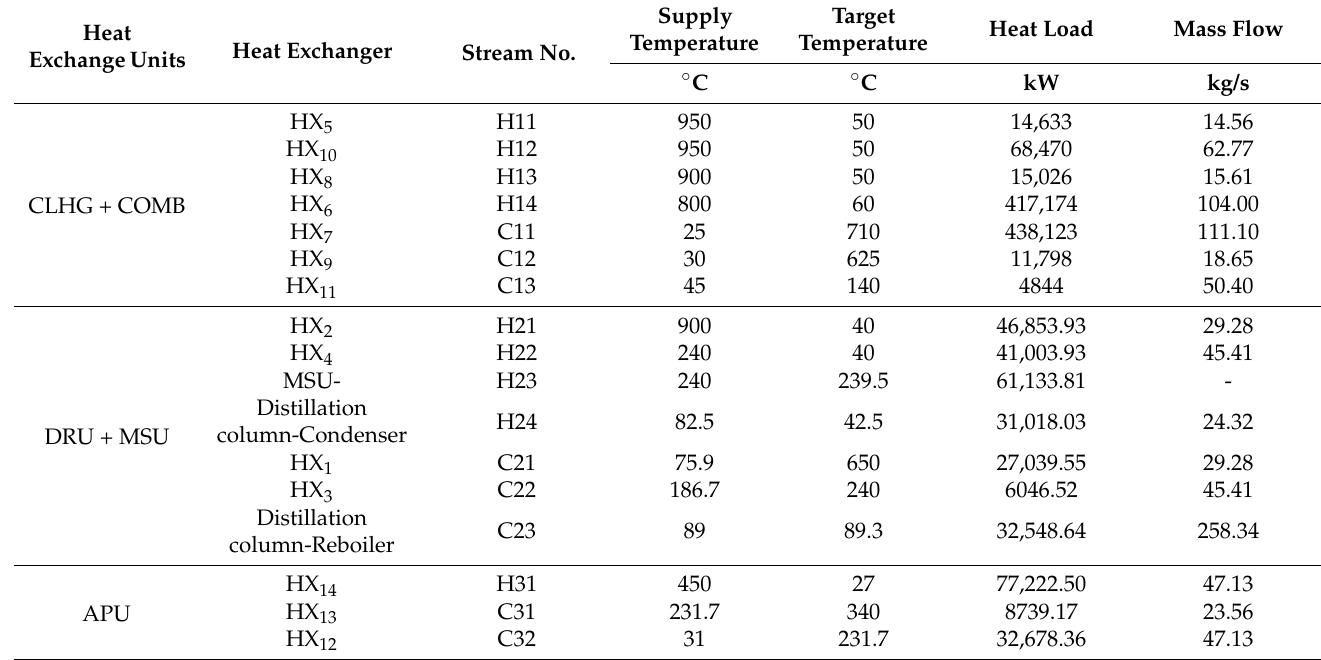
Table 2. Hot and cold flow streams of HEN for CLHG + COMB, DRU + MSU, and